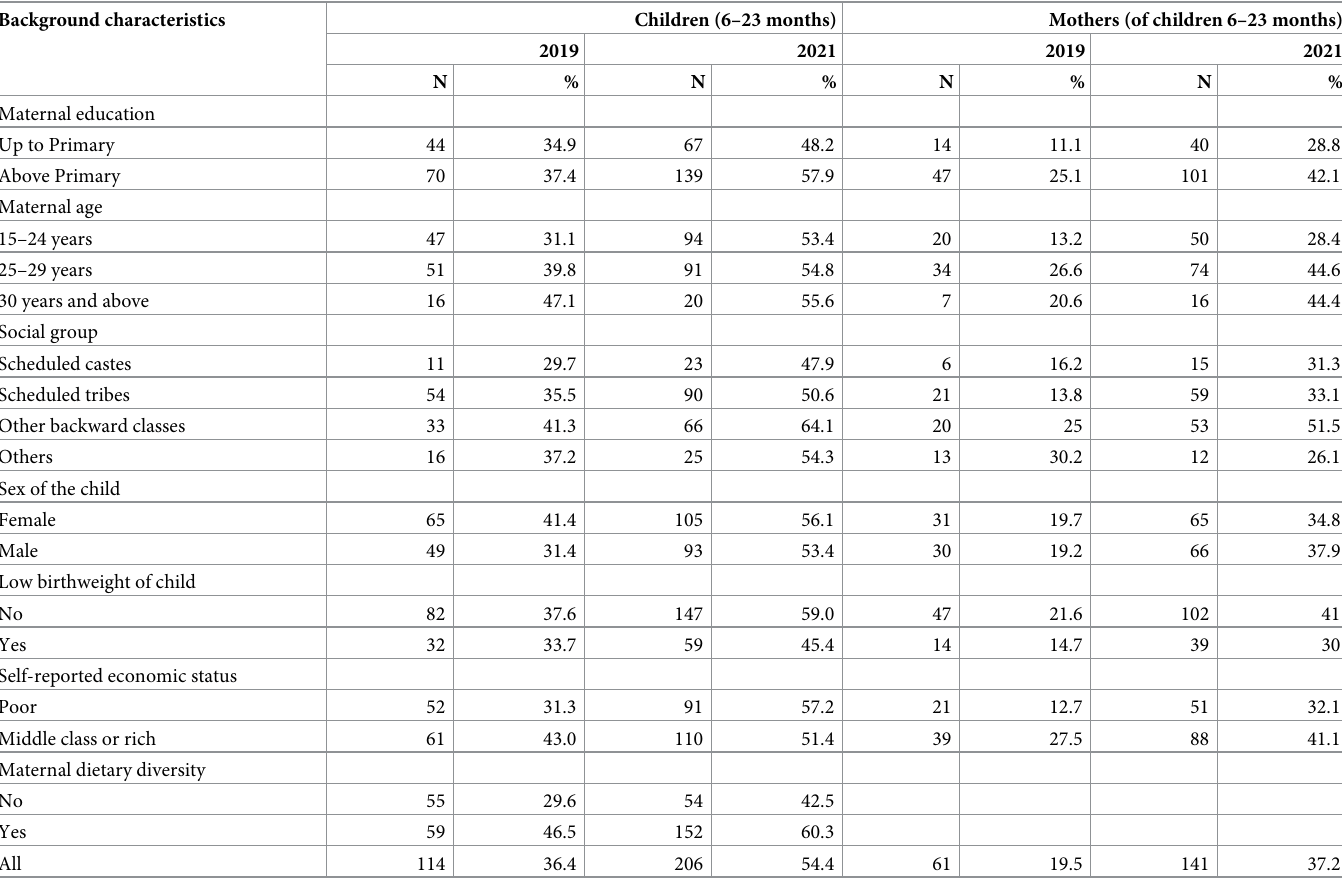
Table 3. Dietary diversity among mothers and children (6–23 months) by background characteristics, Gadchiroli and Chandrapur, 2019 and 2021. Background